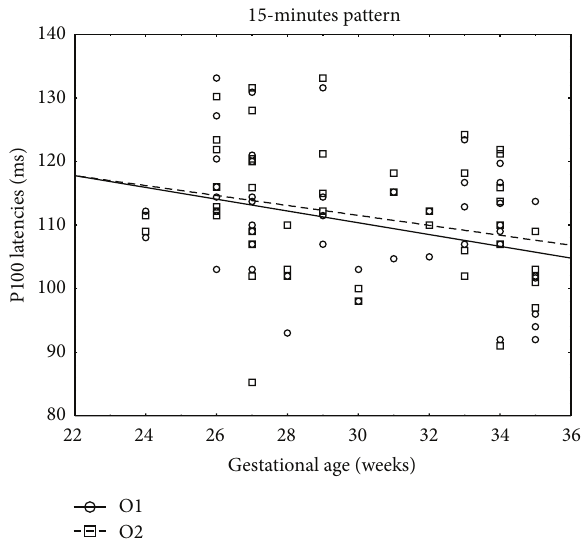
Figure 1: Scatter diagram showing a negative linear correlation between P100 latencies (ms) and birth weight (grams) in 15-minute pattern